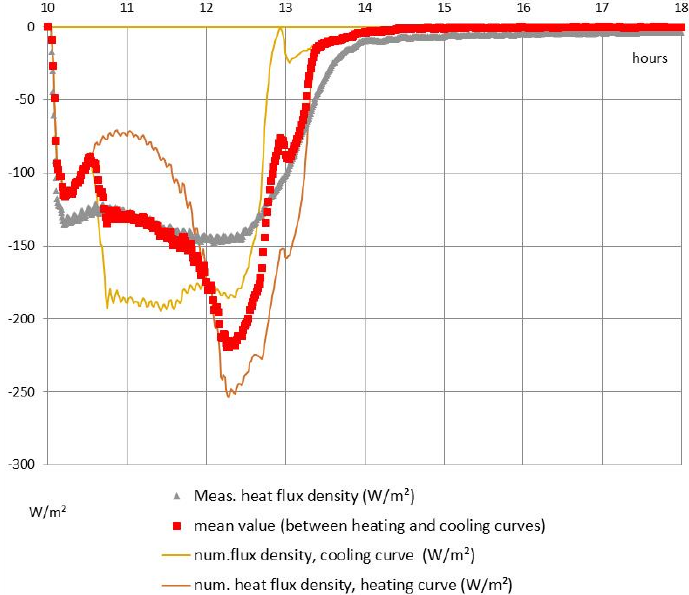
Figure 8. 2D results of mean heat flux to surface container for heating case: heating, cooling heat capacity curves and mean value.